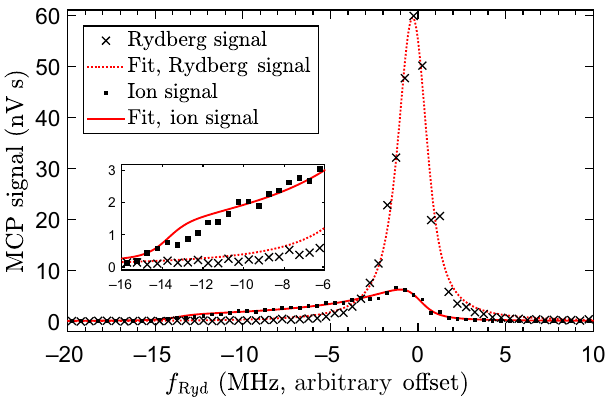
FIG. 5. Rydberg-excitation spectroscopy with n g = 50 and f ICE tuned to (cid:4)ν ICE (cid:7) − 0.365: recorded Rydberg (crosses) and ion (squares) signals as a function of the Rydberg-excitation laser frequency f Ryd . Measurements are binned over a frequency range of 250 kHz, each data point corresponding to the average over 50–100 measurements. The simulation (dotted and plain lines) uses the AI cross section σ (cid:7) 6.14 × 10 − 19 m 2 obtained